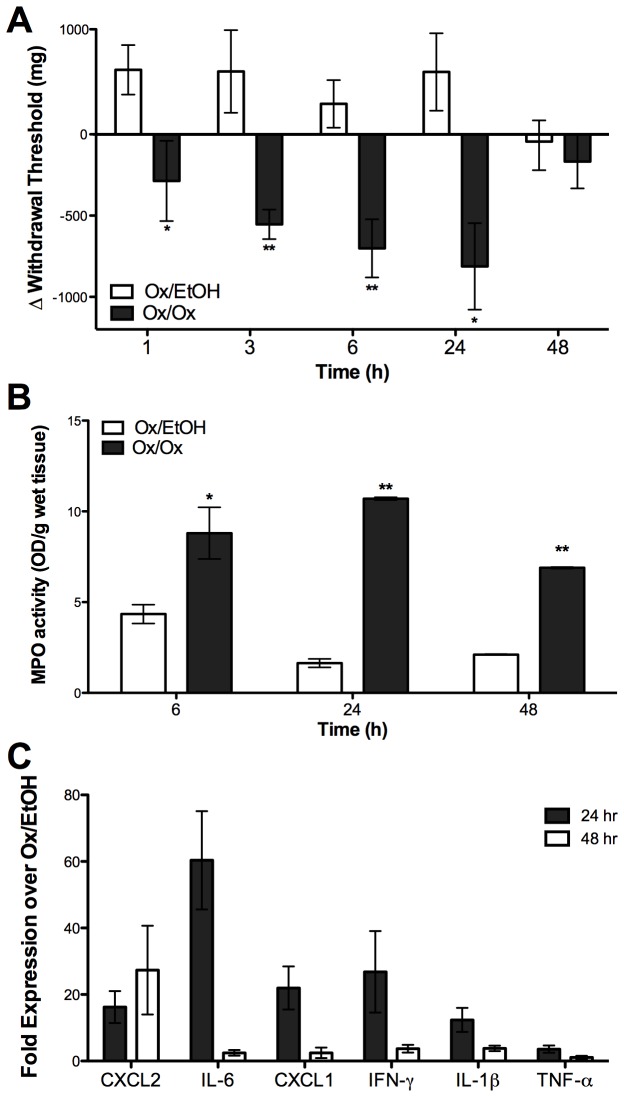
Labiar oxazolone challenge induces acute vulvar mechanical hyperalgesia in sensitized female ND4 Swiss mice.Mice that received a single oxazolone challenge following sensitization show increased mechanical hyperalgesia (A), increased myeloperoxidase activity in the labiar tissue (B), and increased abundance of CXCL2, IL-6, CXCL-1, IFN-γ, IL-1β, and TNF-αmRNAs (C). Significances are compared to Ox/EtOH (* = p<0.05, ** = p<0.01, *** = p< 0.0001respectively). n=3-10 mice per treatment group; data represent at least 2-3 independent experiments.